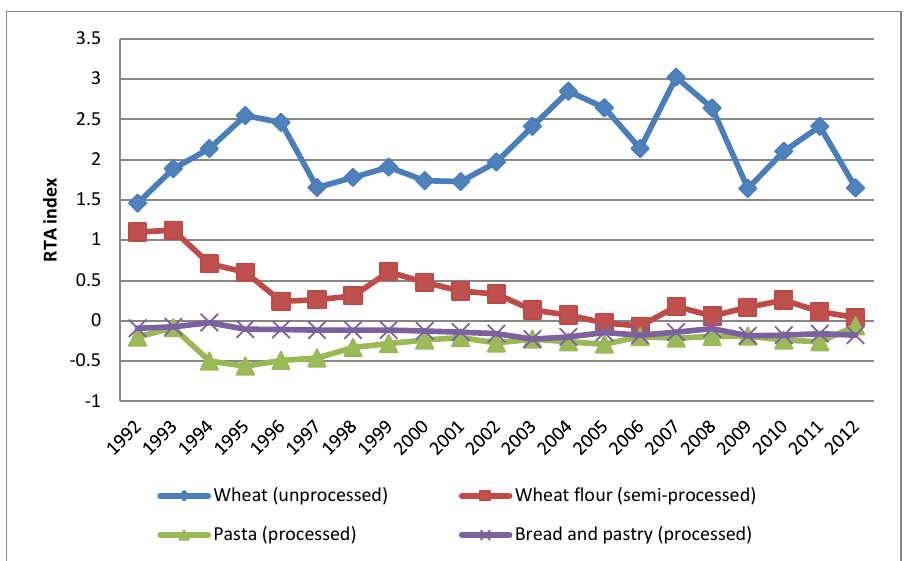
FIGURE A6: Trends in RTA index values for unprocessed, semi-processed and processed wheat in the USA